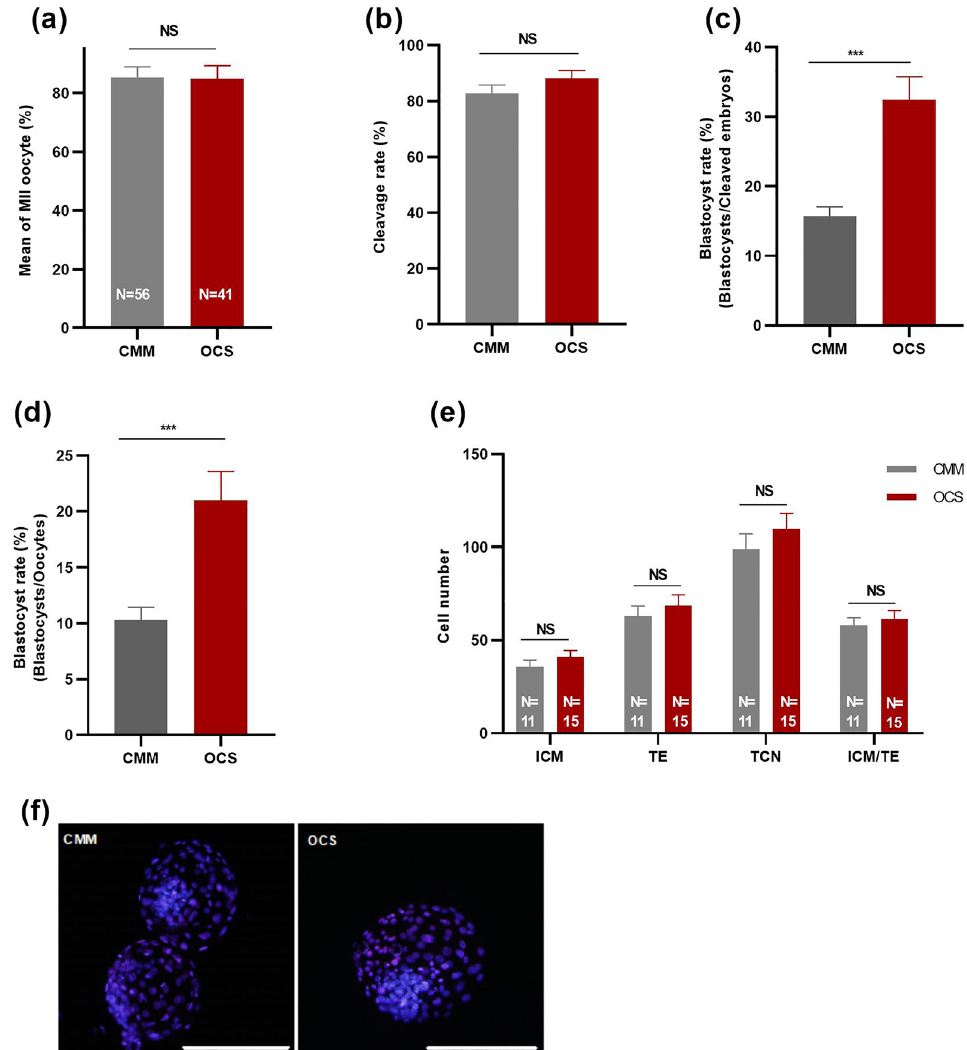
Figure 3. Effect of one carbon supplementation on ( a ) MII oocyte rate, ( b ) Cleavage rate, ( c ) Blastocyst rate (Blastocyst/Cleaved embryos), ( d ) Blastocyst rate (Blastocyst/Oocytes) and ( e ) Embryo cell number. ( f ) Representative images from differential staining of blastocysts of CMM and OCS groups. Magnification 20 ×; Scale bar, 100 µm. ICM inner cell mass, TE trophectoderm cells, TCN total cell number. The data are shown as mean ± s.e.m. NS stands for non-significant differences ( P > 0.05). ***stands for P ≤ 0.001. N stands for number of total oocytes or blastocysts in each group. For embryonic development 12 replications, consisting of 700 oocytes, were done for each